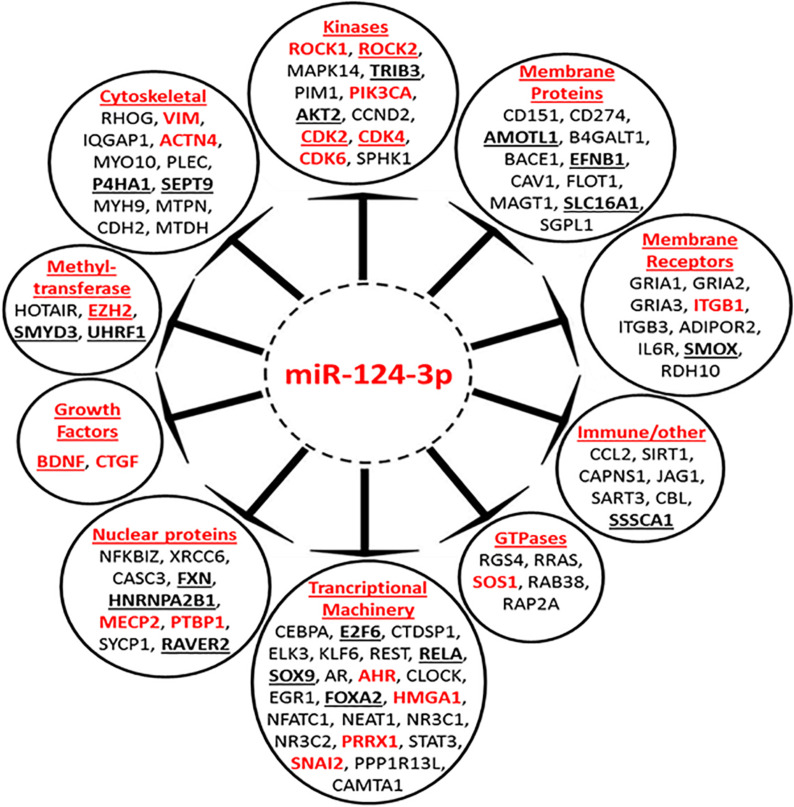
Mir-124-3p direct targets, validated by luciferase reporter assay. Genes in red font have previously been reported to be associated with neuroblastoma. High expression of underlined genes in bold is predictive of poor overall survival in a mixed neuroblastoma cohort. Genes are grouped according to their function.